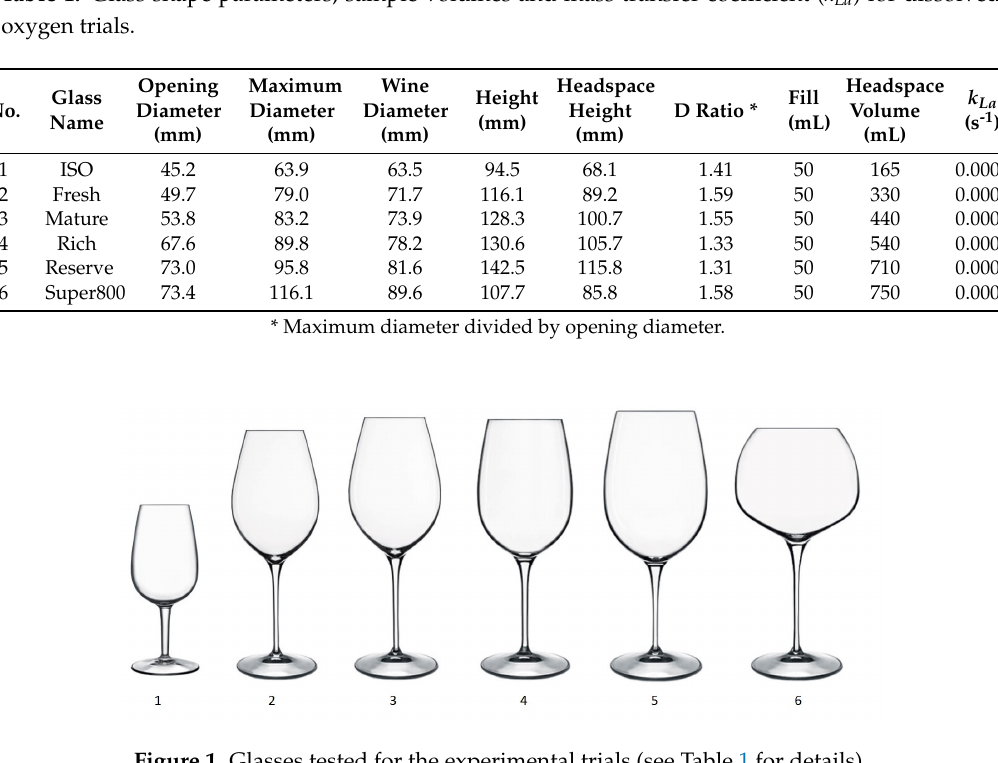
Figure 1. Glasses tested for the experimental trials (see Table 1 for details).